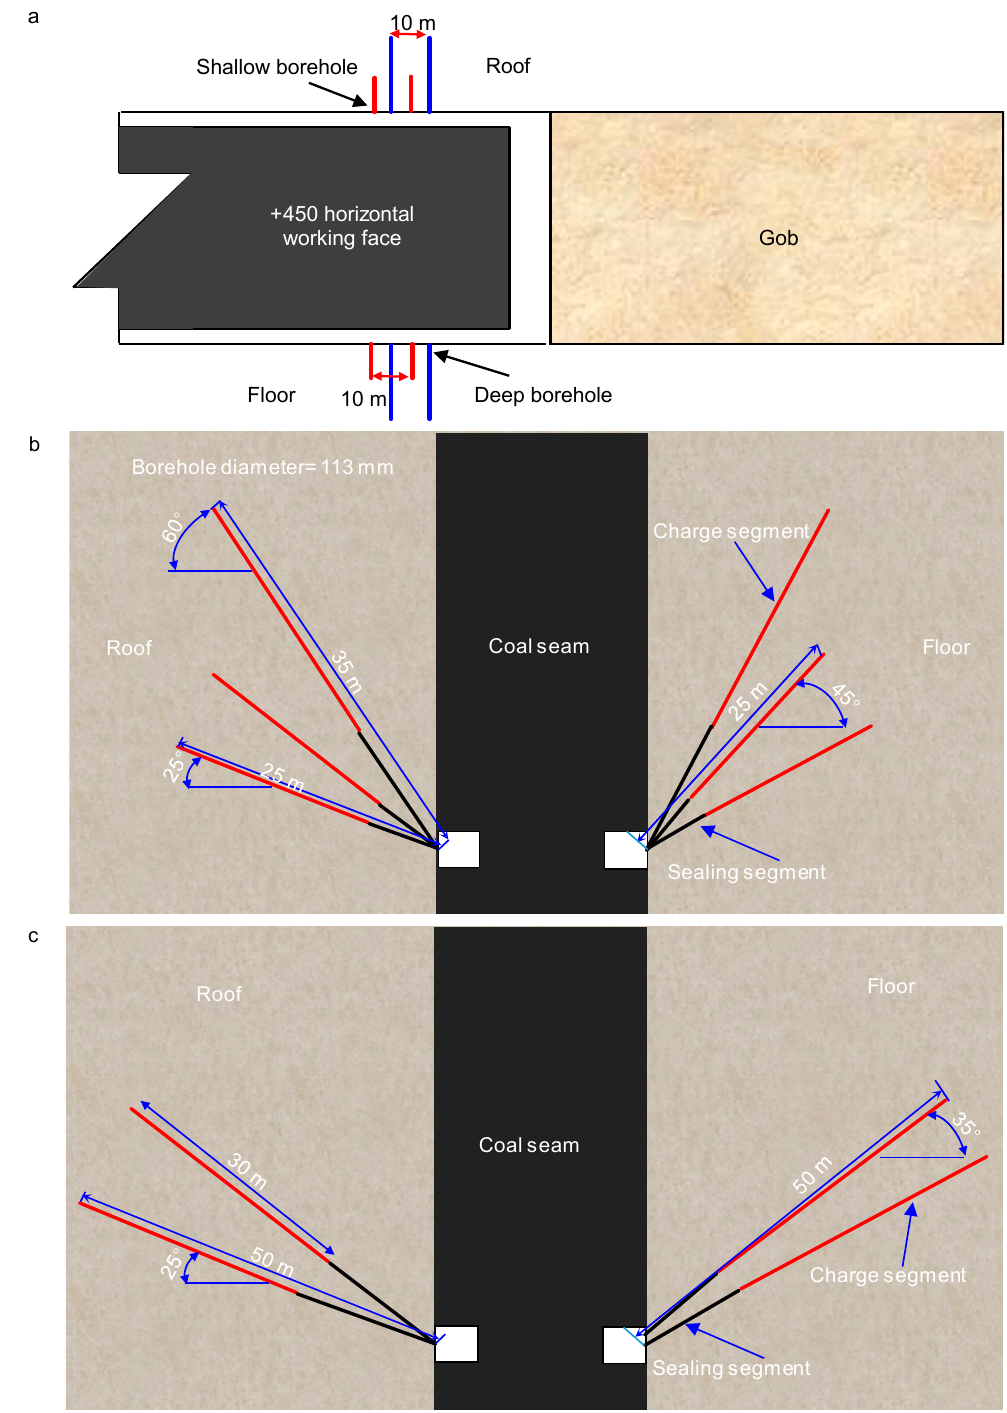
Figure 20. Schematic diagram of pressure-relief boreholes: ( a ) Plan view of the alternate layout of deep and shallow boreholes, ( b ) Sectional plan of shallow de-stress blasting borehole, ( c ) Sectional plan of deep de-stress blasting